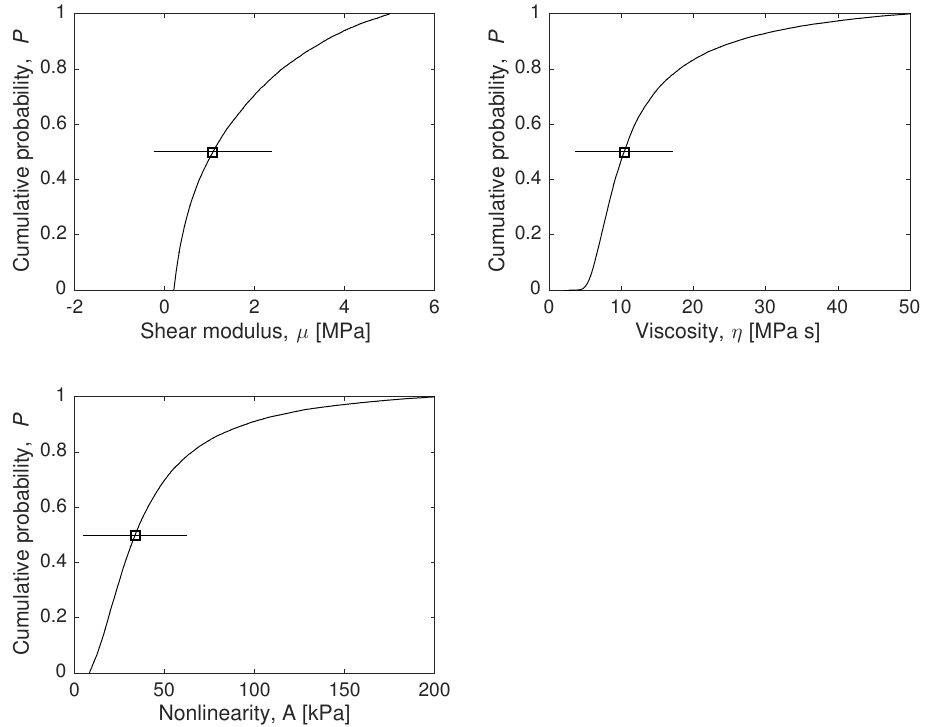
Figure 4. Marginal plausibility maps of model parameters using the model H 1 . The expected values ( p = 50% value) are marked, as well as their standard deviation